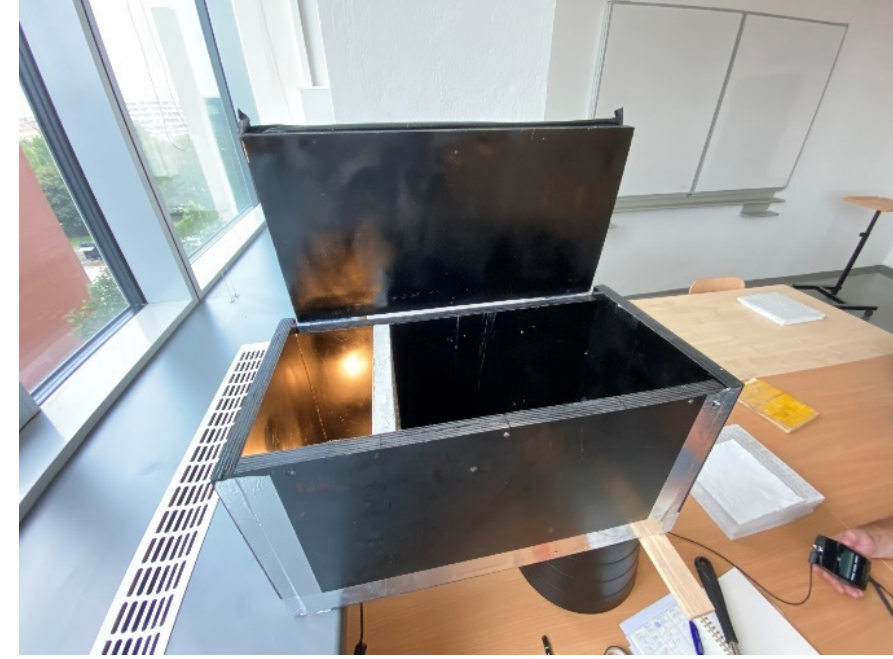
Figure 29. Down-scaled model for measurement.